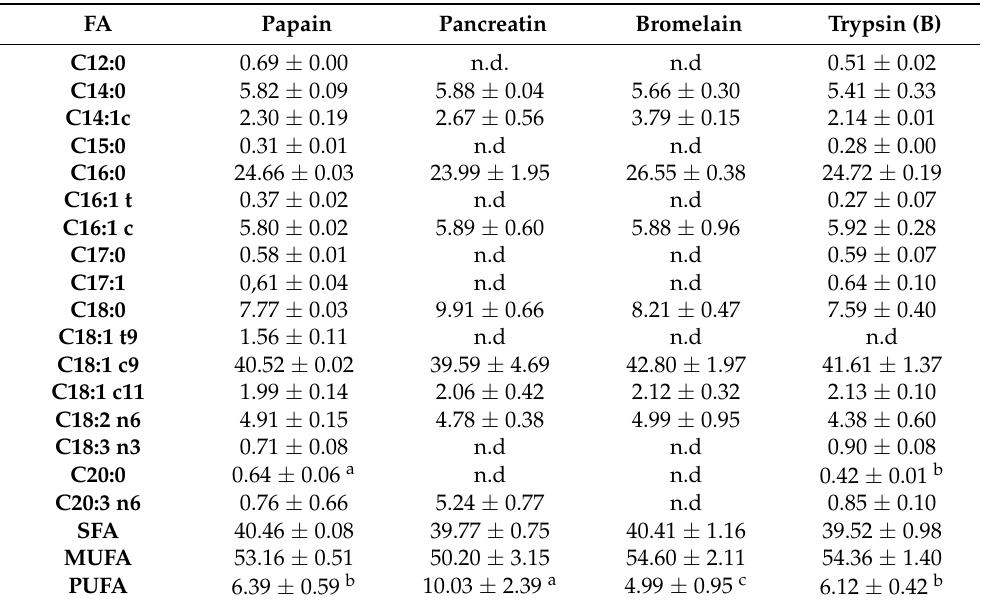
Table 4. Fatty acids (FA) identification and quantification of the hydrolysates obtained by enzymatic hydrolysis of fleshing meat. FA Papain Pancreatin Bromelain Trypsin